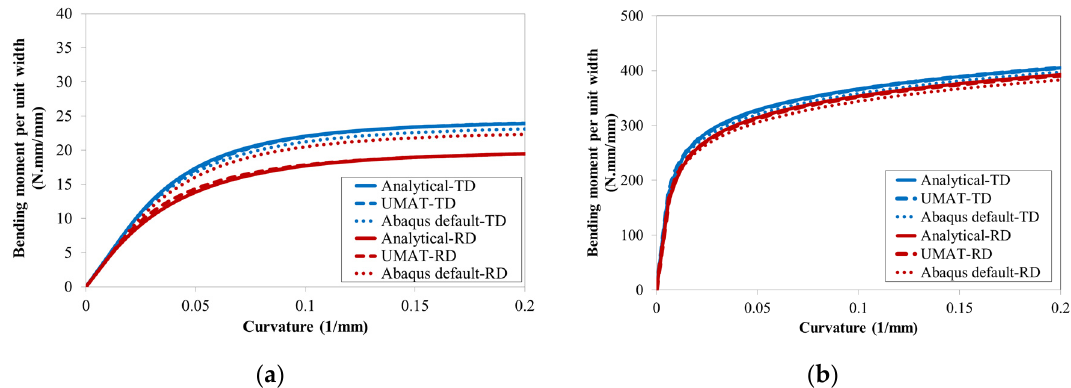
Figure 11. Comparisons of numerical and analytical bending moment–curvature diagrams: ( a ) SUS304; ( b ) DP980.